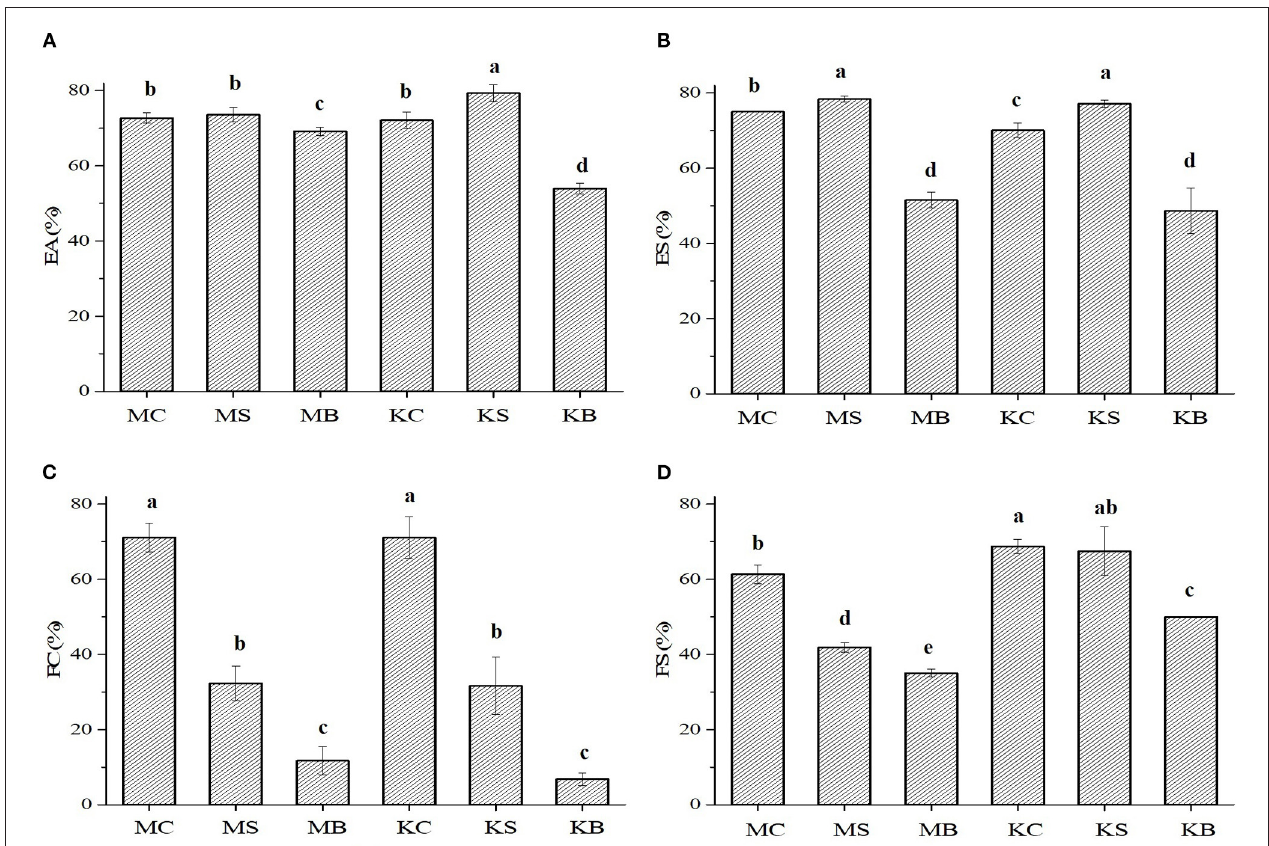
FIGURE 2 | Emulsifying capacity (EA) (A) , emulsion stability (ES) (B) , foaming capacity (FC) (C) and foam stability (FS) (D) of flours produced from untreated mung bean (control) (MC); soaked mung bean (MS); soaked + boiled mung bean (MB); untreated red kidney bean (control) (KC); soaked red kidney bean (KS); soaked + boiled red kidney bean (KB). Significant differences among samples are indicated by different letters ( p <